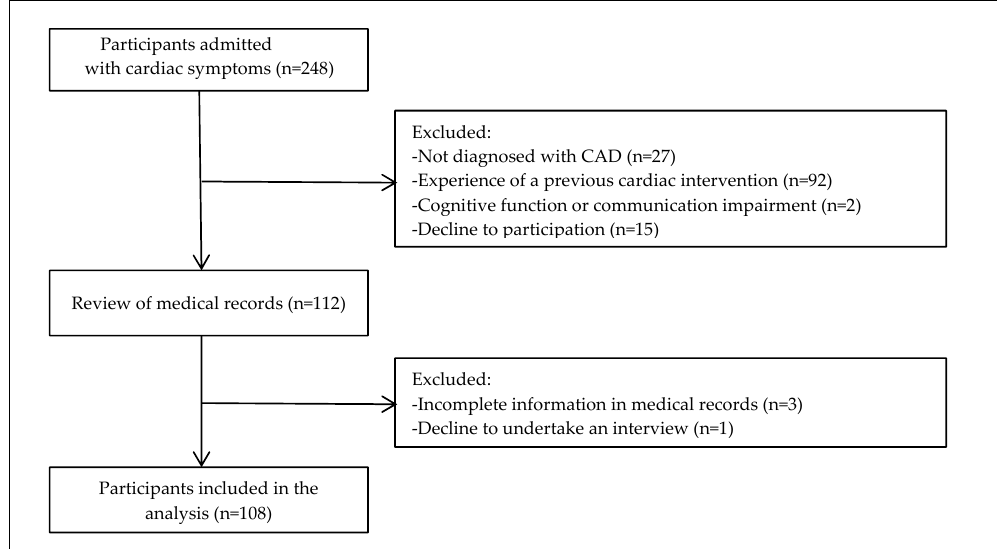
Figure 1. Flowchart of study population.